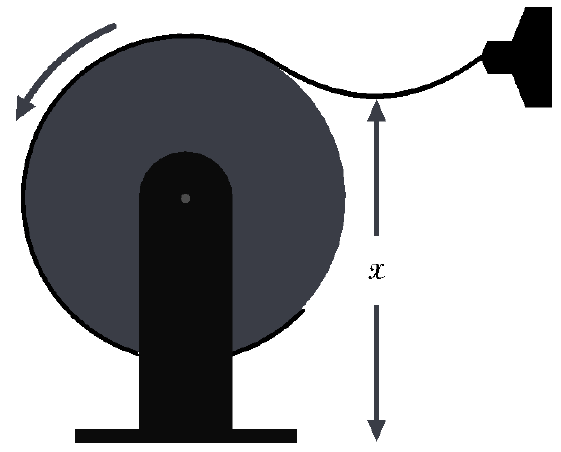
Figure 2. Digested hemp fibre ( a ) and digested harakeke fibre ( b ).